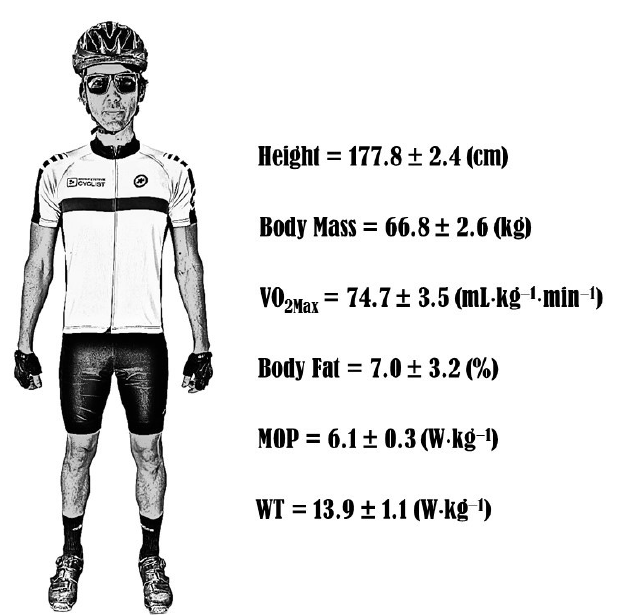
Figure 7. General profile of a male professional cyclist. Values are mean ± SD of the professional cyclist’s data described in Table 4 and in Section 8.1. VO 2Max : maximal oxygen uptake; MOP: maximal oxidative power; WT: Wingate test.